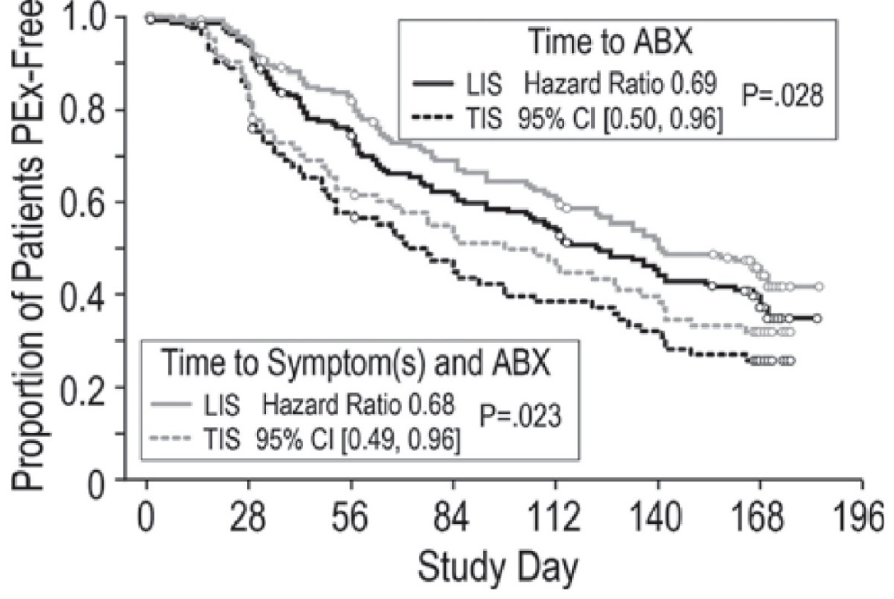
Figure 2. Difference in time to PEx as first antipseudomonal antibiotic (ABX) treatment (black lines) and ABX treatment in the presence of symptoms (gray lines) from Fischer R. et al., Pediatr. Pulmonol. 2016 , Suppl 45 , 359,doi:10.1002/ppul.23573